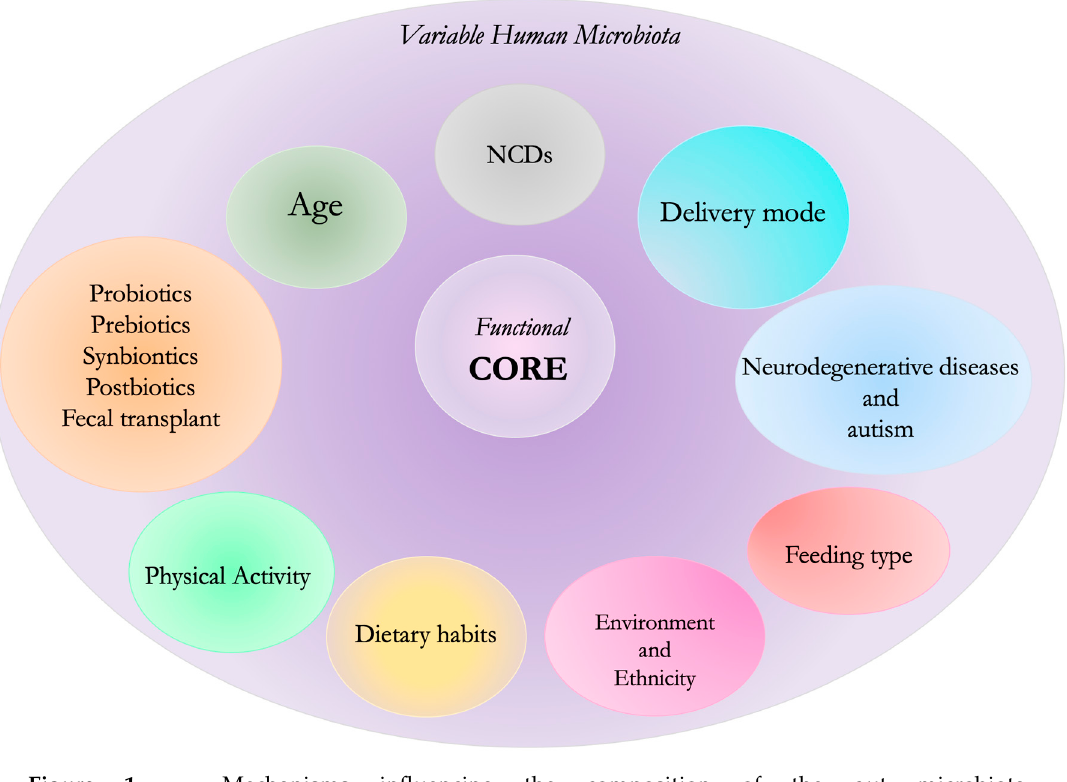
Figure 1. Mechanisms influencing the composition of the gut microbiota. NCDs, chronic non-communicable diseases.